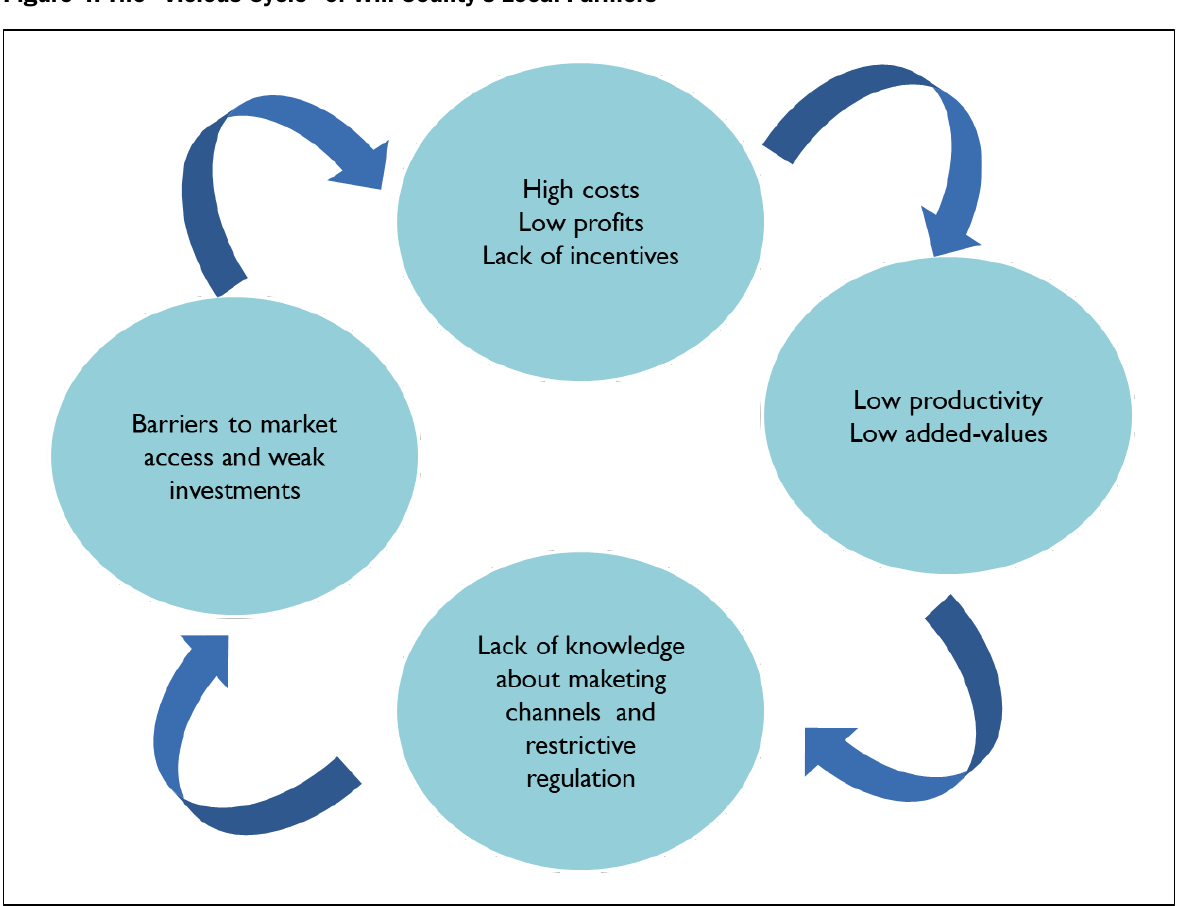
Figure 4. The “ Vicious Cycle ” of Will County ’ s Local